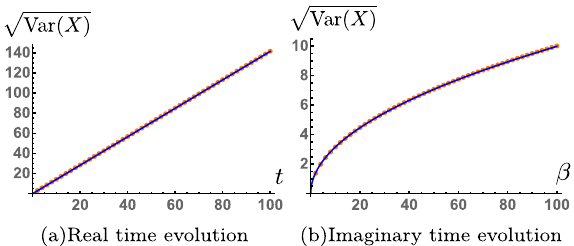
FIG. 2. Comparison between real-time evolution and imaginary time evolution in the tight-binding model (16) with R ¼ 500 . In ffiffiffiffiffiffiffiffiffiffiffiffiffiffiffi p (a) and (b), we plot the fluctuation of the position Var ð X Þ after the real and imaginary time evolutions, respectively. Here, the state at the initial time is given by j 0 i . The fitting functions for (a) ffiffiffi p 2 t and 0 . 998769 β 1 = 2 , respectively. This and (b) are given by clearly indicates that the real-time evolution induces a ballistic propagation, whereas the imaginary-time evolution induces a diffusive